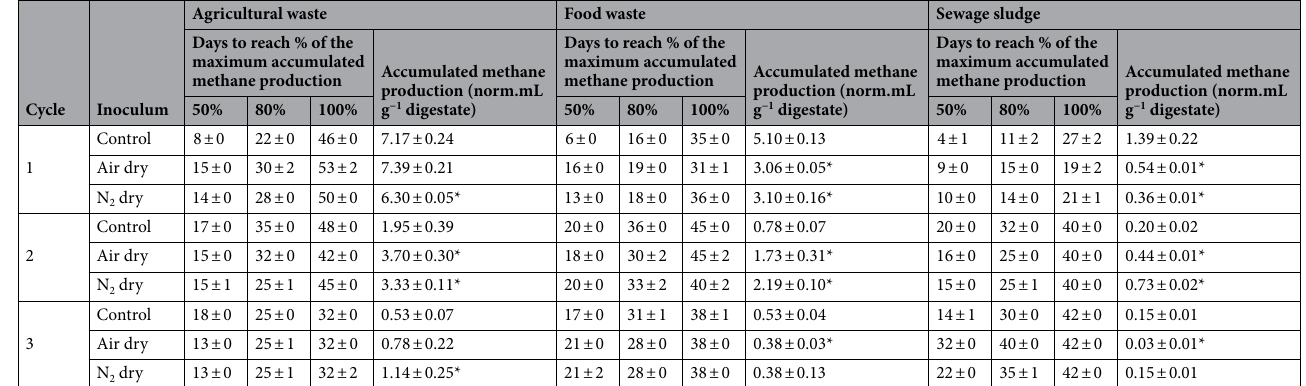
Table 1. Accumulated methane production of the three types of digestate and the time taken to reach 50, 80 and 100% of the production. One hundred percent of the maximum accumulated methane production (average ± SD, n = 3) was reached when the daily methane production was less than 0.5% of its accumulated value. Student t-test was performed to compare the difference in accumulated methane production with two- drying treatments to their control group in each cycle, respectively. Significant differences were marked with “*” when p <